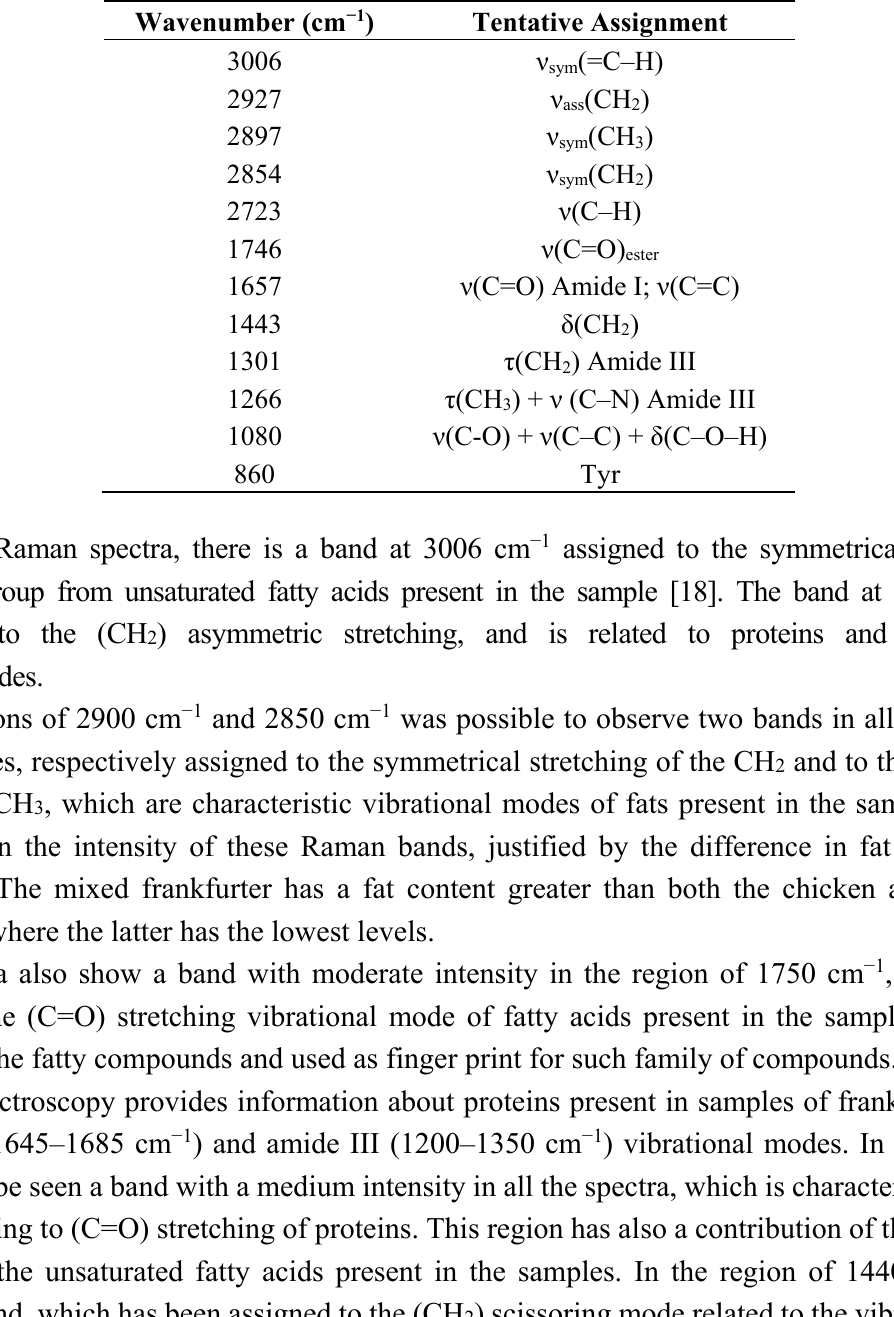
Table 1. Tentative assignment of the Raman spectrum of frankfurters, based on similar systems described on literature